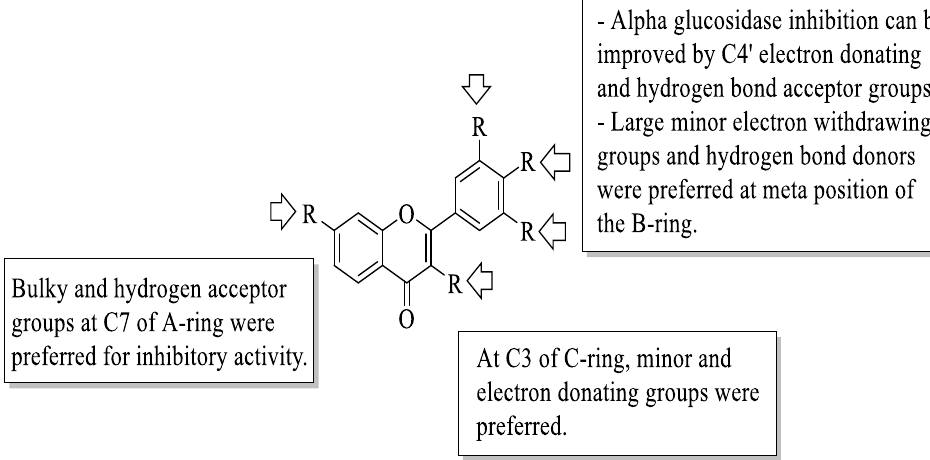
Figure 19. The SAR of flavonoids for α -glucosidase inhibition activity [56]. Potipiranun et al. isolated several flavonoids to test their activities on antidiabetic complication (AGE inhibition) and α -glucosidase inhibition [57]. Three flavanones, two chalcones, and two dihydrochalcones were isolated from Boesenbergia rotunda , which is known as fingerroot. Based on Figure 20, flavanones consist of pinocembrin ( 68 ), pinos- trobin ( 69 ), and alpinetin ( 70 ). Meanwhile, chalcones are cardamomin ( 71 ) and boesenber- gin B ( 72 ), whereas dihydrochalcones are panduratin A ( 73 ) and isopanduratin ( 74 ). For the evaluation of AGE inhibition, two methods were conducted, namely AGE inhibition assay and methylglyoxal (MG) trapping activity. MG is a known precursor of gly- cation. It was reported that most compounds showed greater AGE inhibition than the control, aminoguanidine. Then, for MG trapping activity, all compounds showed compa- rable activities compared to aminoguanidine. Briefly, 68 was the most active compound for MG trapping activity, with an EC 50 value of 63.22 ± 10.12 µM. By using the structure of 68 and other compounds, the SAR of flavonoids on the MG trapping activity was sum- marized. Firstly, hydroxy groups can improve the inhibition, while methoxy and geranyl groups can reduce the inhibition. Next, the presence of a methoxy group at the C7 position of dihydrochalcone can improve the activity compared to methoxy groups at the C5